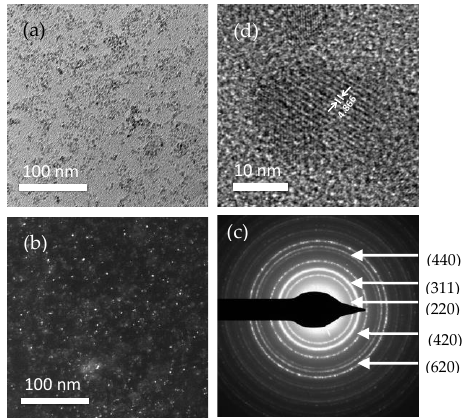
Figure 3. TEM images of the CS-coated MnFe 2 O 4 nanoparticles at pH 11. ( a ) bright field (BF), ( b ) dark-field (DF), ( c ) selected area diffraction (SAED) pattern, and ( d ) high-resolution TEM image.